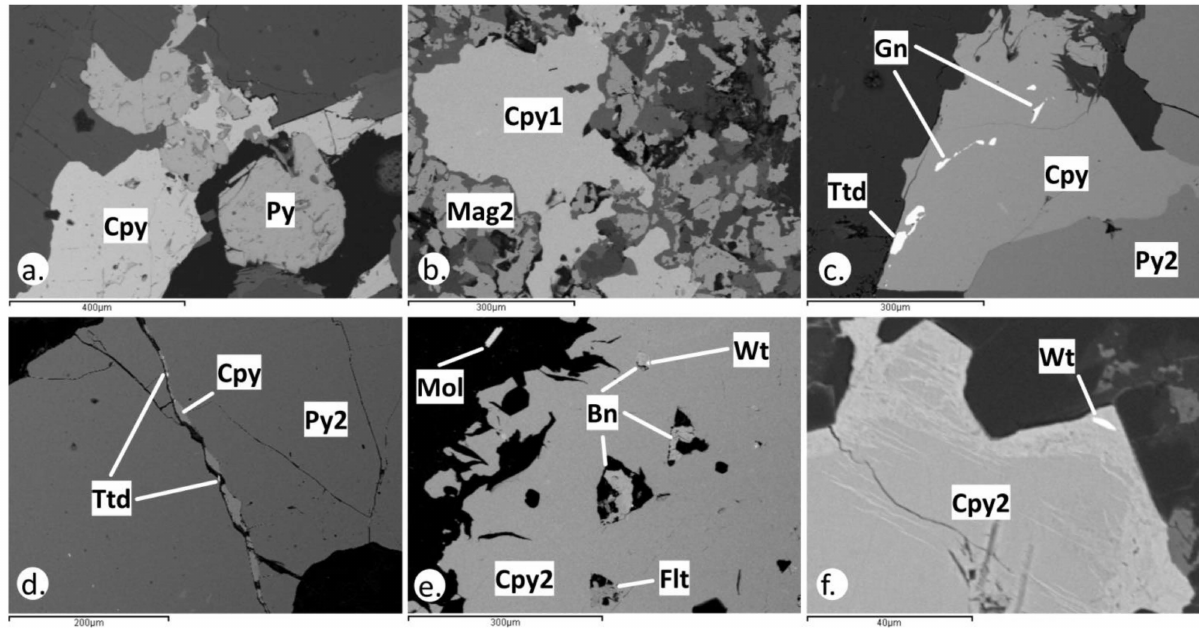
Figure 7. SEM back-scattered electron images of chalcopyrite from different mineralization stages from the quartz monzonite ( a – c ) and the latite ( d – f ): ( a ) chalcopyrite (Cpy) is intergrown with pyrite (Py) in A-type vein from potassic alteration; ( b ) chalcopyrite (Cpy1) overgrowth on magnetite (Mag2) aggregates from potassic alteration; ( c ) chalcopyrite (Cpy) is intergrown with pyrite (Py2) and bears inclusions of galena (Gn) and tetradymite (Ttd) from sericitic alteration; ( d ) chalcopyrite (Cpy) and traces of tetradymite (Ttd) fill a crack running across a D-type vein with massive pyrite (Py2) from sericitic alteration; ( e ) chalcopyrite (Cpy2) and euhedral inclusions of bornite (Bn), fletcherite (Flt), and molybdenite (Mol); traces of wittichenite (Wt) are found in bornite (Bn) from sericitic alteration; ( f ) chalcopyrite (Cpy2) and wittichenite (Wt) from sericitic